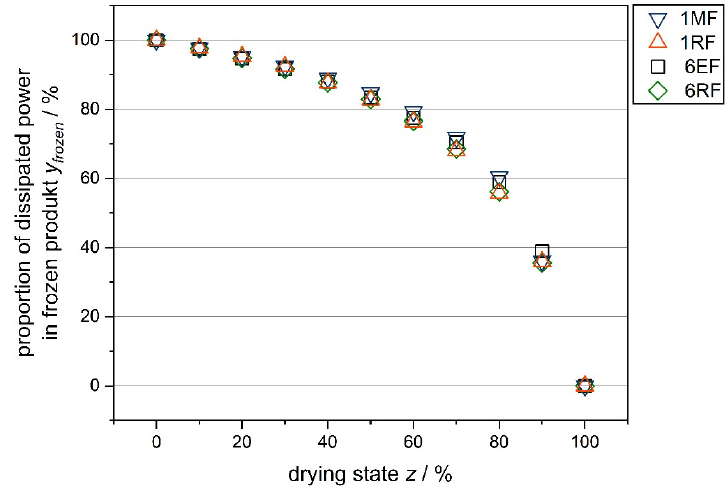
Figure 11. The proportion of power dissipation in an exemplary cuboid made of tylose gel (top left in Figure 1a) in the frozen region relative to the total power dissipation in the respective cuboid as a function of the drying state for the investigated control concepts, obtained from the electromag- netic simulations.